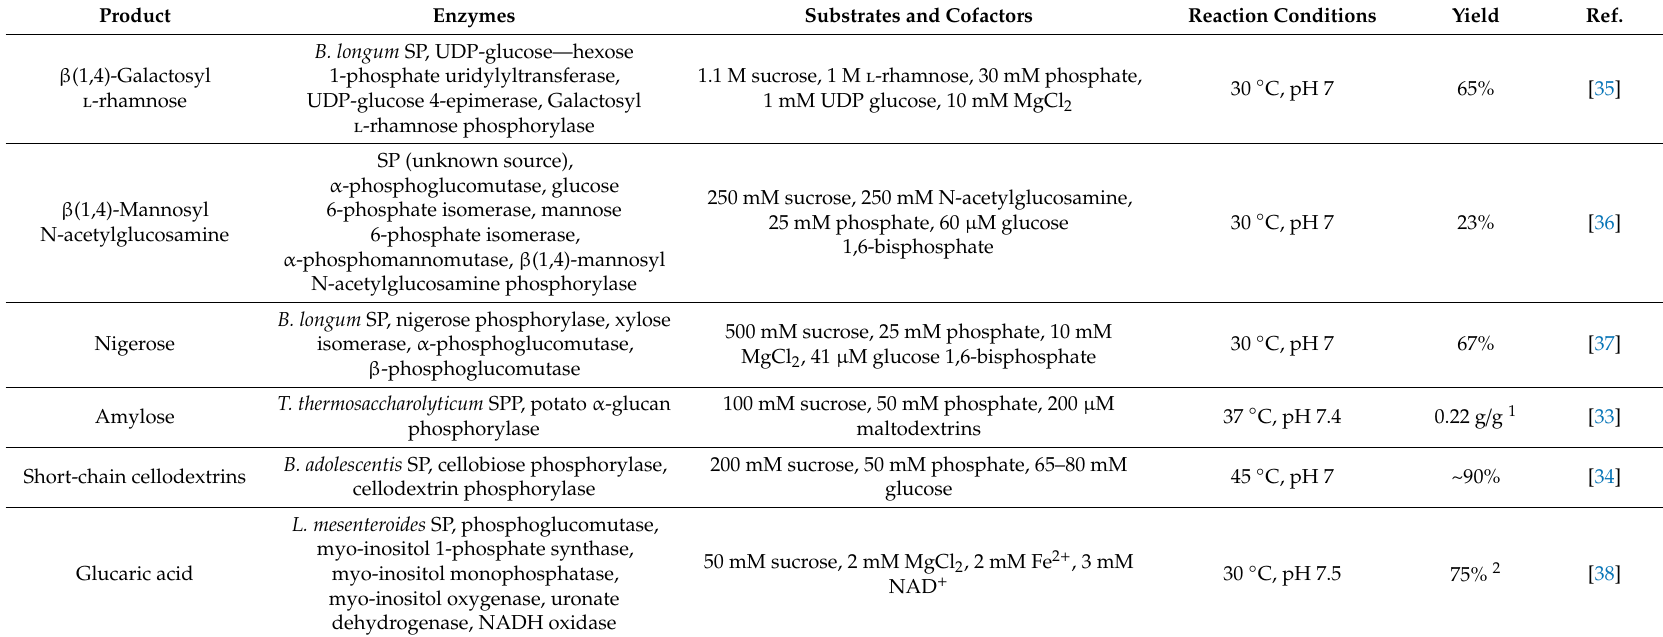
Table 1. One-pot enzyme cascade reactions that include SP activity for the generation of Glc1P. Yields are relative to